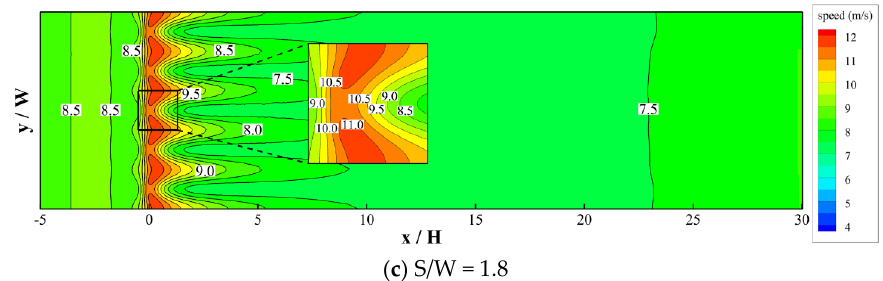
Figure 13. Pedestrian wind speed contours for different tree spaces (H = 15 m).